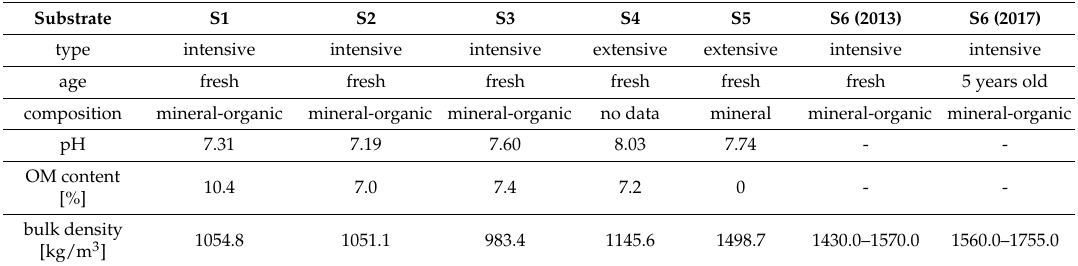
Table 1. Characteristics of substrates used in the